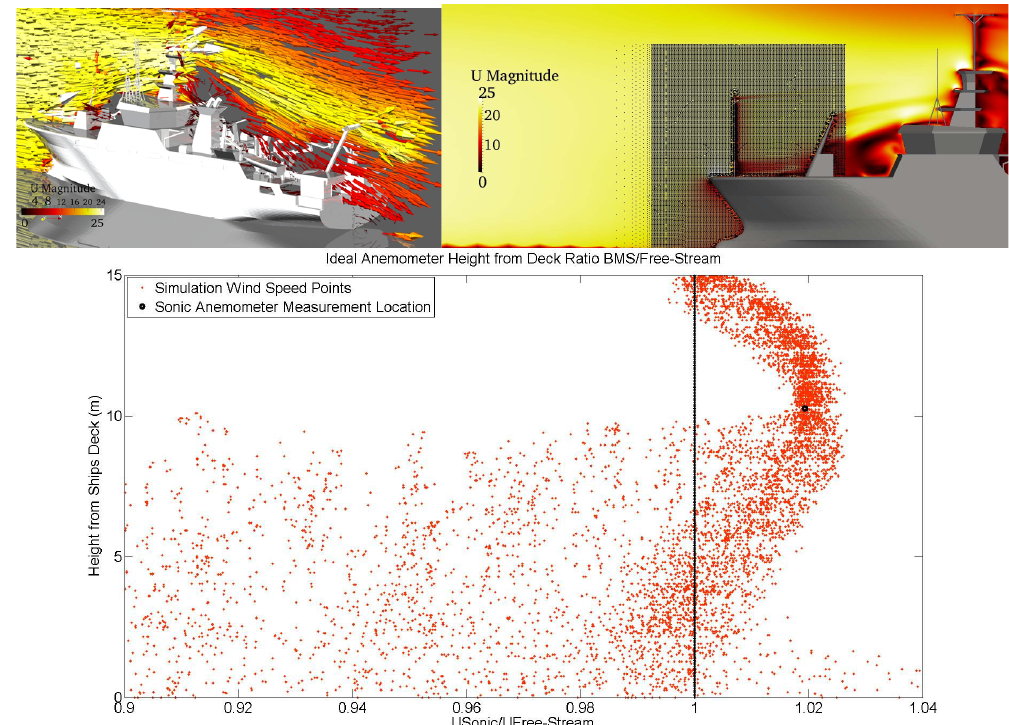
Fig. 9. Top left: cross-sectional velocity vector plot from 5 to 25ms − 1 . Top right: grid location for determination of optimised position of the BMS. Bottom: ratio of BMS anemometer to free stream for the data points in the grid above. The black dot indicates the current location of the BMS